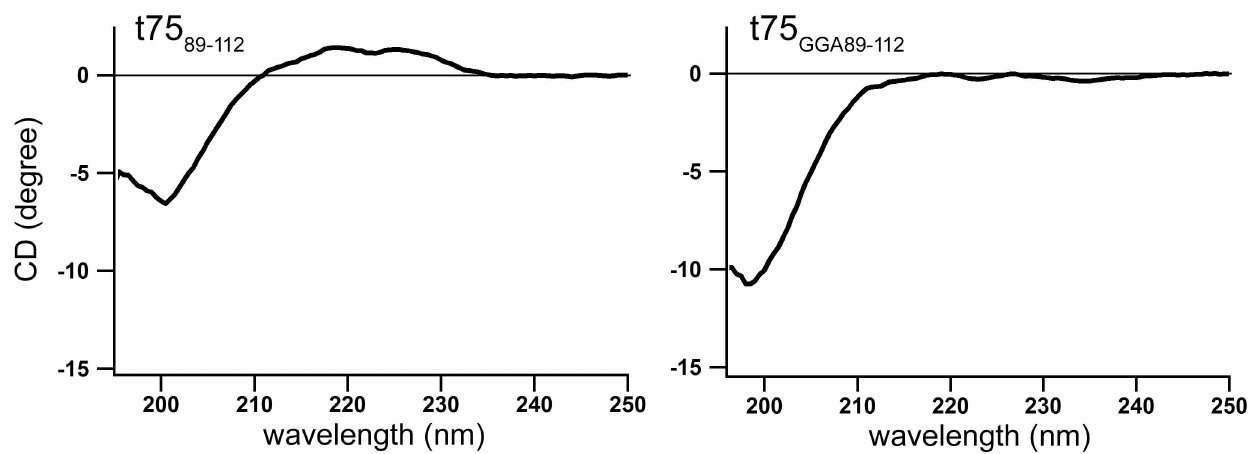
Fig 7. Far UV CD spectrat75 89-112 variants at 20˚C. Each spectrum is the averageof eight